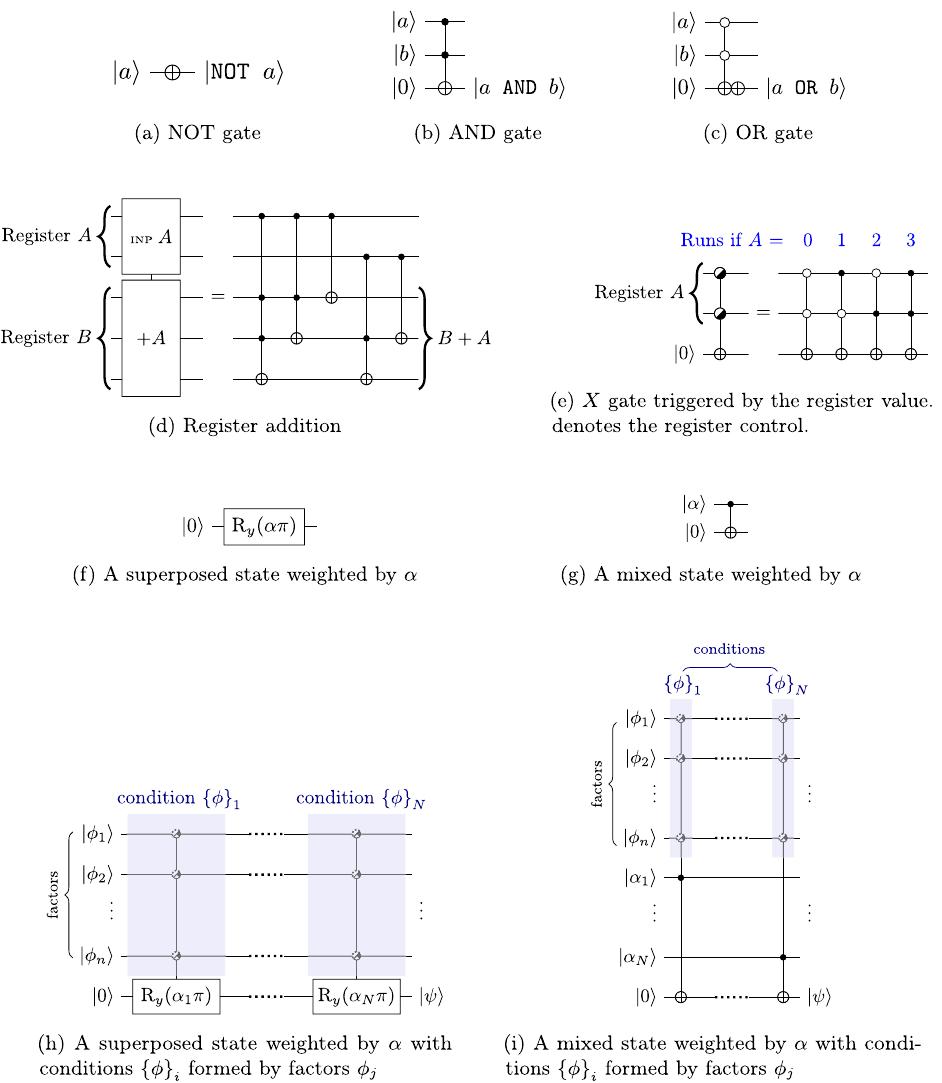
Figure 3. Some building blocks of quantum gates in the “little endian representation”. The symbol may represent a